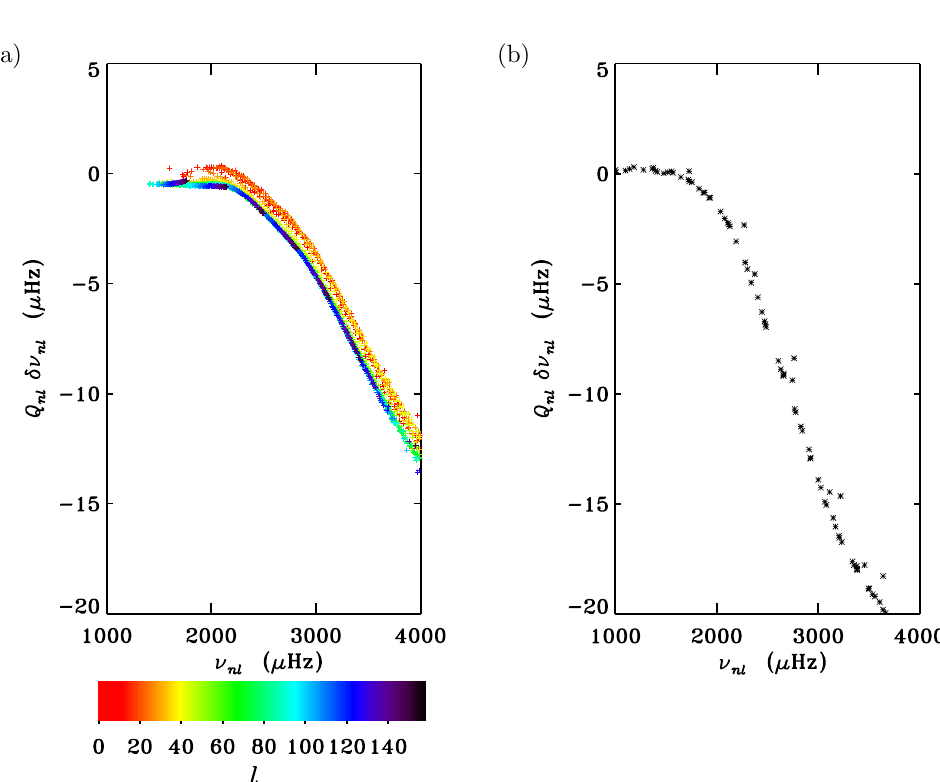
Figure 2: (a) Scaled differences between observed GONG frequencies and adiabatically computed fre- quencies of the ‘standard’ solar Model S. The degree 𝑙 of the oscillation modes is indicated by the colour bar. Image reproduced with permission from Christensen-Dalsgaard et al. (1996), copyright by AAAS. (b) Scaled adiabatic frequency differences between a model for which the near-surface layers were rep- resented by a hydrodynamical simulation, and the ‘standard’ solar Model S, which does not include the turbulent pressure. Image adapted from Rosenthal et al.